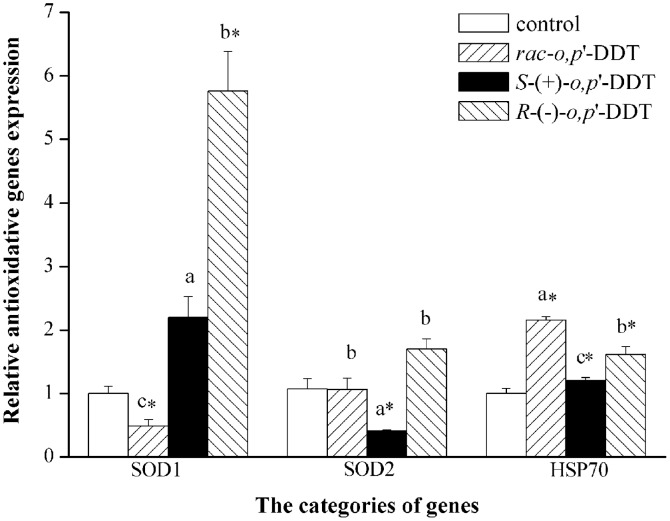
Oxidative stress related gene induction by racemate and enantiomers of o,p’-DDT.The relative expression of anti-oxidative related genes encoding superoxide dismutase (SOD1 and SOD2) and heat shock protein (HSP) genes in response to racemate and enantiomers of o,p’-DDT. The asterisk denoted p<0.05 relative to the negative control. Different letters above adjacent bars indicate a significant difference (p<0.05) between individual enantiomers or between an enantiomer and racemate, while the same letter indicates no significant difference.